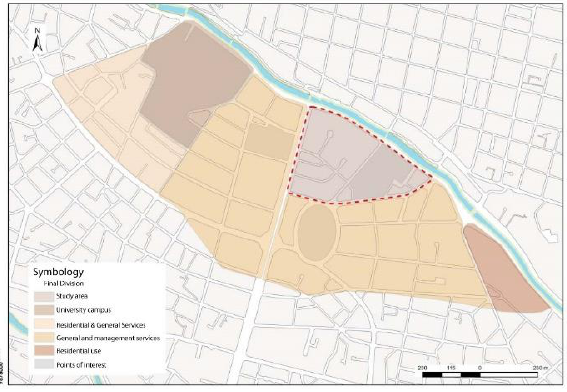
Figure 7. Delimitation of the study area. Source: